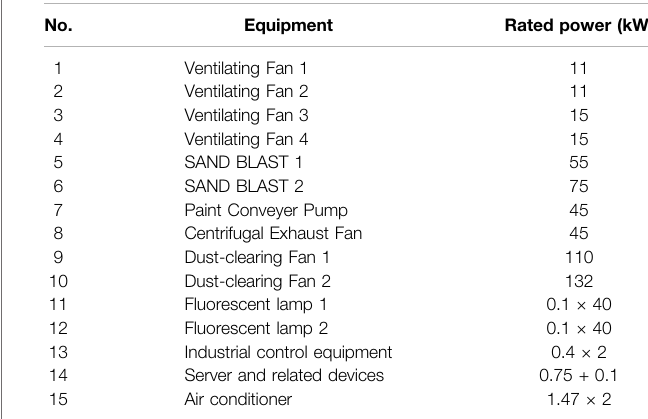
TABLE 2 | List of equipment in the